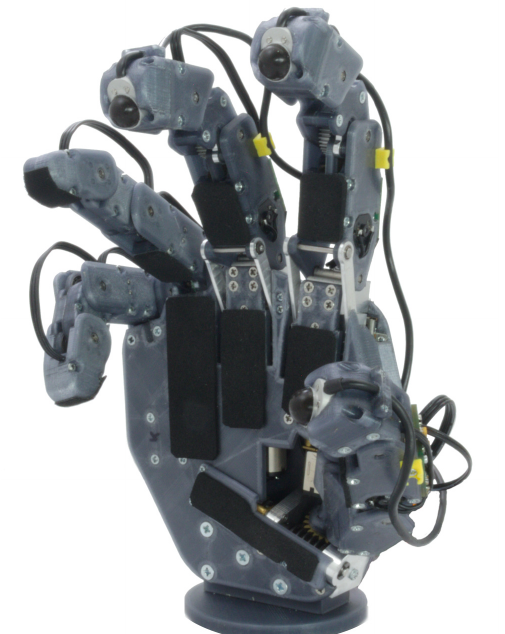
Figure 3. PUT-Hand—an open-source dexterous robotic hand.